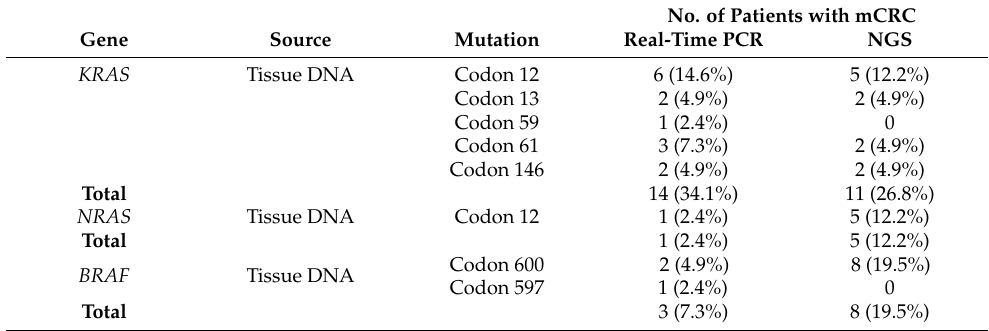
Table 4. KRAS , NRAS , and BRAF mutations detected by PCR and NGS in patients with mCRC ( n =